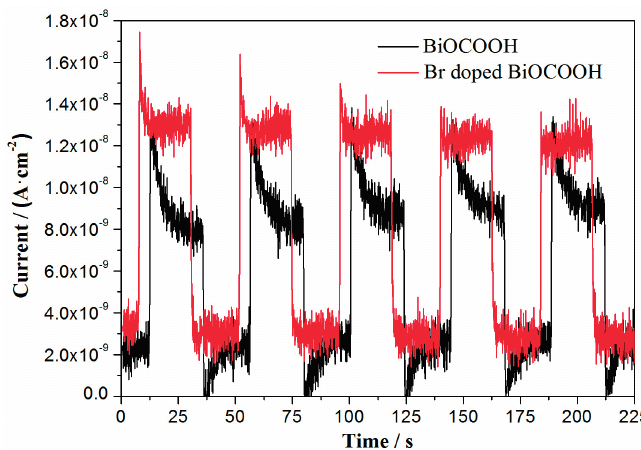
Figure 8. Photocurrent generation for BiOCOOH and Br-doped BiOCOOH (BHB-0.25) under visible light irradiation ( λ > 420 nm, [Na 2 SO 4 ] = 0.5